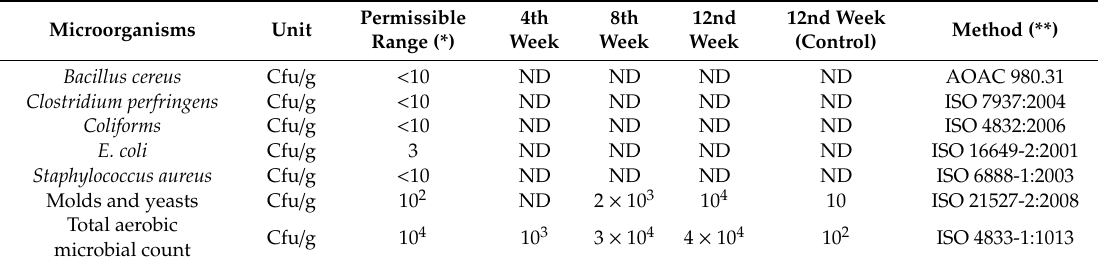
Table 7. Microbial testing results of sponge cake after di ff erent storage periods at 37 ◦